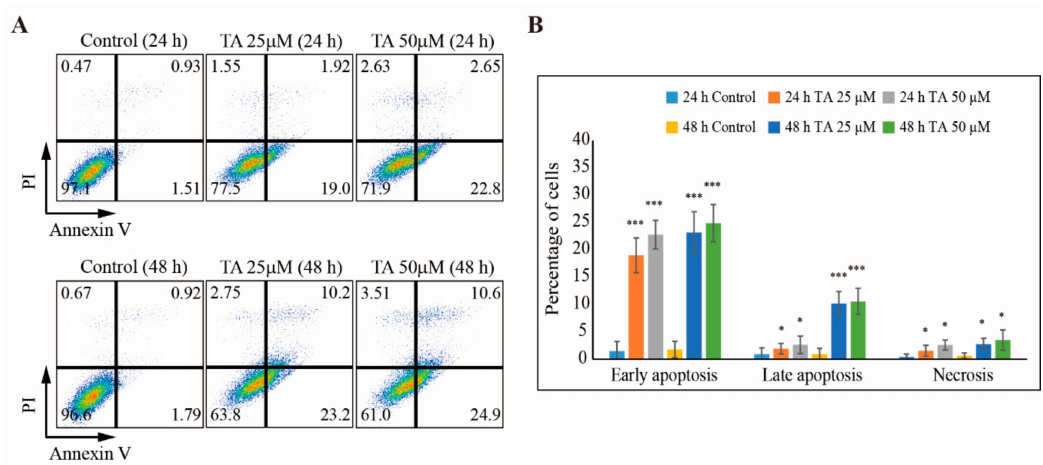
Figure 4. TA induces apoptosis in NCCIT cells. ( A ) Fluorescein-conjugated annexin V (annexin V-FITC) vs. propidium iodide (PI) staining analysis showing apoptosis induction after treatment with 25 µ M and 50 µ M TA for 24 h and 48 h in NCCIT cells. ( B ) Graphical representation of the percentage of apoptotic cells upon control, 25 µ M, and 50 µ M TA treatment for 24 h and 48 h obtained from